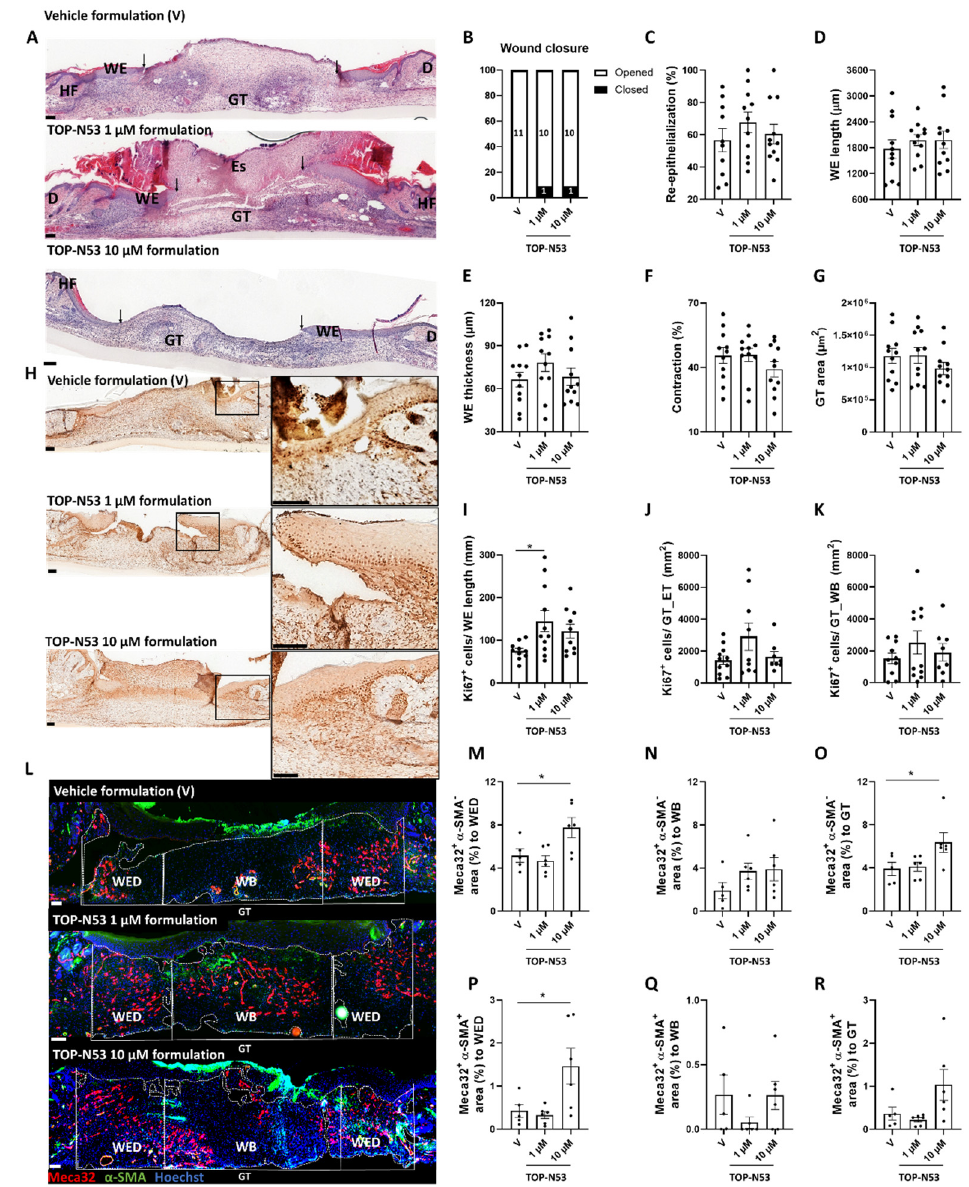
Figure 3. TOP-N53 liquid hydrogel formulation promotes keratinocyte proliferation and angiogenesis in wounds of healthy C57BL/6J mice. ( A ) Representative photomicrographs of hematoxylin/eosin-stained paraffin sections from 5-day wounds of mice treated with vehicle hydrogel formulation (V) or TOP-N53 1 or 10 µM liquid hydrogel formulation. Magnification bars: 100 µm. D: Dermis, Es: Eschar, GT: Granulation tissue, HF: Hair follicle, WE: wound epidermis. Black arrows indicate the position of the epithelial tongue. ( B ) Percentages of open (white bars) and closed (black bars) 5-day wounds based on histological sections. n = 11 (vehicle; V); n = 11 (1 µM) or n = 11 (10 µM). ( C ) Percentage of wound re-epithelialization, including open and closed wounds, n = 10–11 wounds per treatment group. ( D , E ) Length ( D ) and average thickness (epidermis area/epidermis length) (E) of the wound epidermis (WE). n = 11 wounds. ( F ) Percentage of wound contraction based on the initial wound length (5 mm). n = 11 wounds. ( G ) Area of GT. n = 11 wounds. ( H ) Representative photomicrographs of wound sections stained for Ki67. Magnification bars: 100 µm. Ki67 + cells per mm wound epidermis ( I ) or mm 2 granulation tissue area below the epithelial tongue ( J ) or in the wound bed ( K ). n = 10–11 wounds. ( L ) Representative photomicrographs of wound sections stained for Meca-32 (red) and α -smooth muscle actin (SMA) (green) and counterstained with Hoechst (blue). White dashed lines define the different areas of the granulation tissue. Magnification bars: 100 µm. Percentage of GT tissue area at the wound edge area (WED) stained positive for Meca32 ( M ) or in the wound bed (WB) ( N ) or total GT ( O ). n = 5–6 wounds.